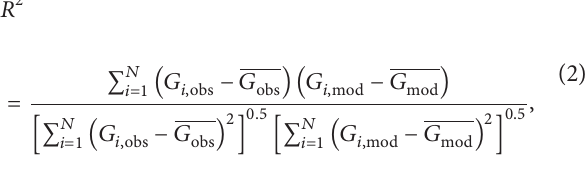
𝑅 2 represents the percentage of the data that is close to